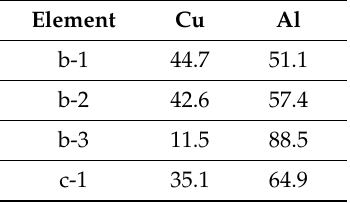
Figure 13. Fracture morphology along the thermomechanical influence zone of aluminum plate: ( a ) Macroscopic morphology; ( b ) Lower morphology; ( c ) Middle morphology; ( d ) Upper morphology. Table 3. The content of copper and aluminum in di ff erent